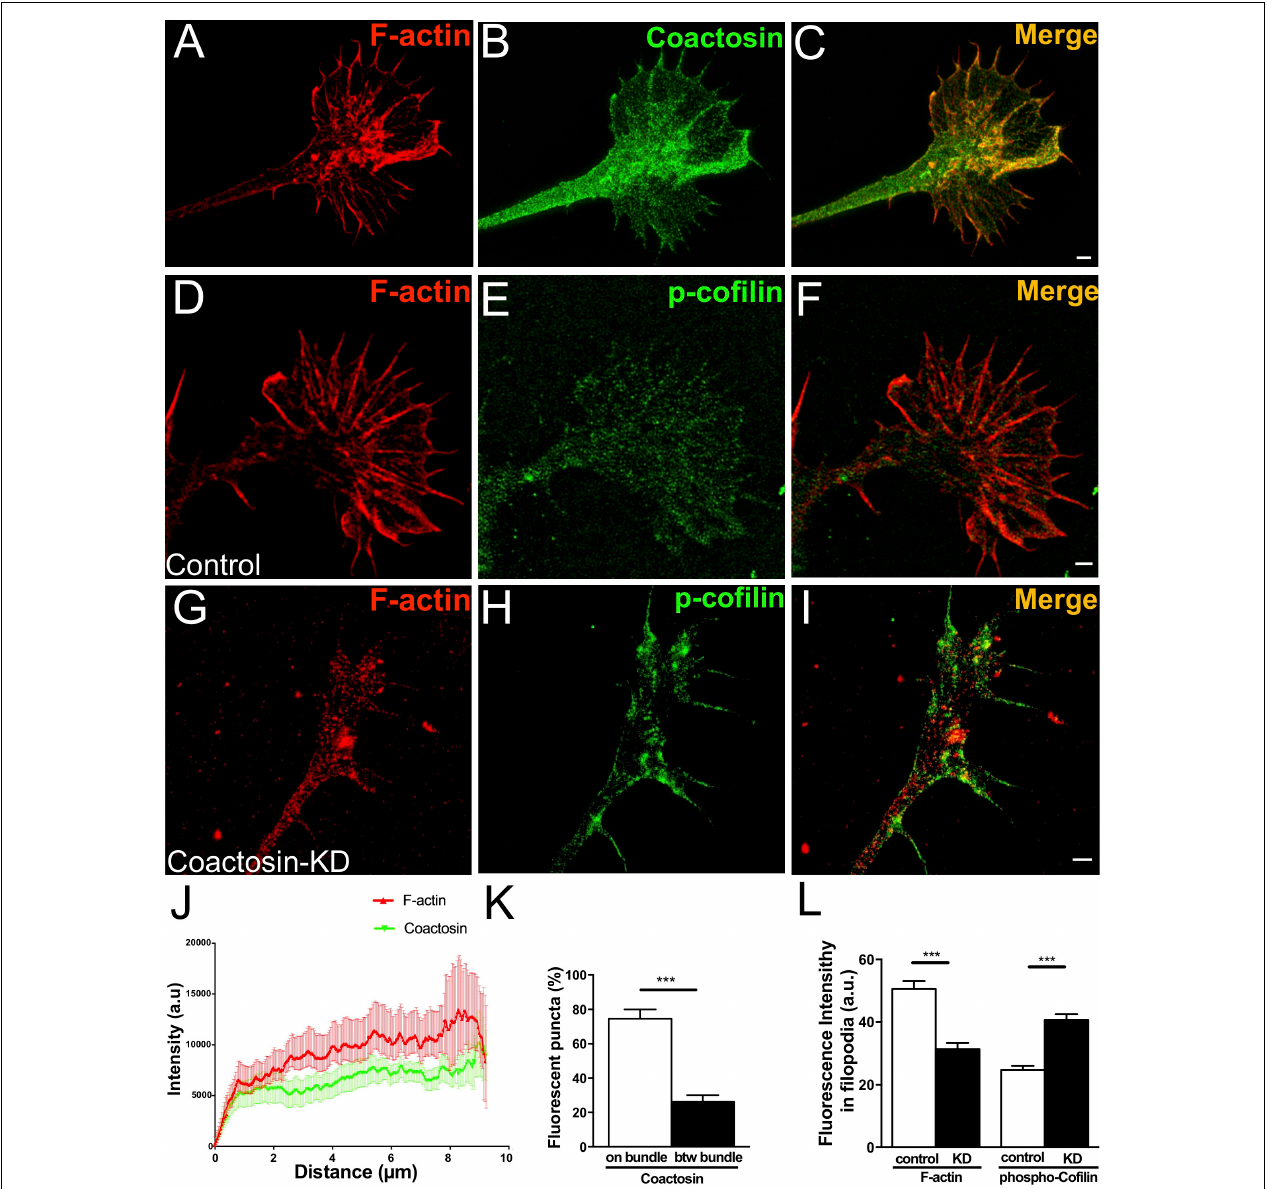
FIGURE 5 | Concentration of coactosin signals needs at F-actin bundles. (A–C) Structured illumination microscopy (SIM) images showing endogenous coactosin and F-actin in the growth cone of an oculomotor neuron. Double staining of coactosin ( green ) and rhodamine-phalloidin ( red ) showing coactosin accumulation on F-actin bundles. (D–I) Representative SIM images of control (D–F) and coactosin-knockdown (G–I) neurons with double staining of phosphorylated cofilin ( p -cofilin: green ) and rhodamine-phalloidin ( red ). With coactosin knockdown, the actin array and bundle structures were disorganized and showed strong p -cofilin expression around the filopodia. (J) Quantitative distribution of the fluorescence intensities of coactosin ( green ) and F-actin (rhodamine-phalloidin, red ). Measurements were performed 9 µ m from a filopodial tip ( n = 16 for coactosin and n = 24 for F-actin, means ± SEM). (K) Quantitative analysis of the association of coactosin or cofilin with F-actin. Approximately 75% of the coactosin-positive pixels were located on actin bundles (“on bundle”), while the rest of them were located between actin bundles (“btw bundle”). The data are shown as means ± SEM (25 bundles for each, *** p = 0.0001, Mann–Whitney U -test). (L) Quantitative fluorescence intensities of F-actin (rhodamine-phalloidin, red ) and p -cofilin ( green ) in filopodia. Coactosin knockdown caused reduction of F-actin but accumulation of p -cofilin within filopodia (29 filopodia in 5 cells for each, *** p = 0.0002 for F-actin, p = 0.0005 for p -cofilin, Mann–Whitney U -test). Scale bars, 1 µ